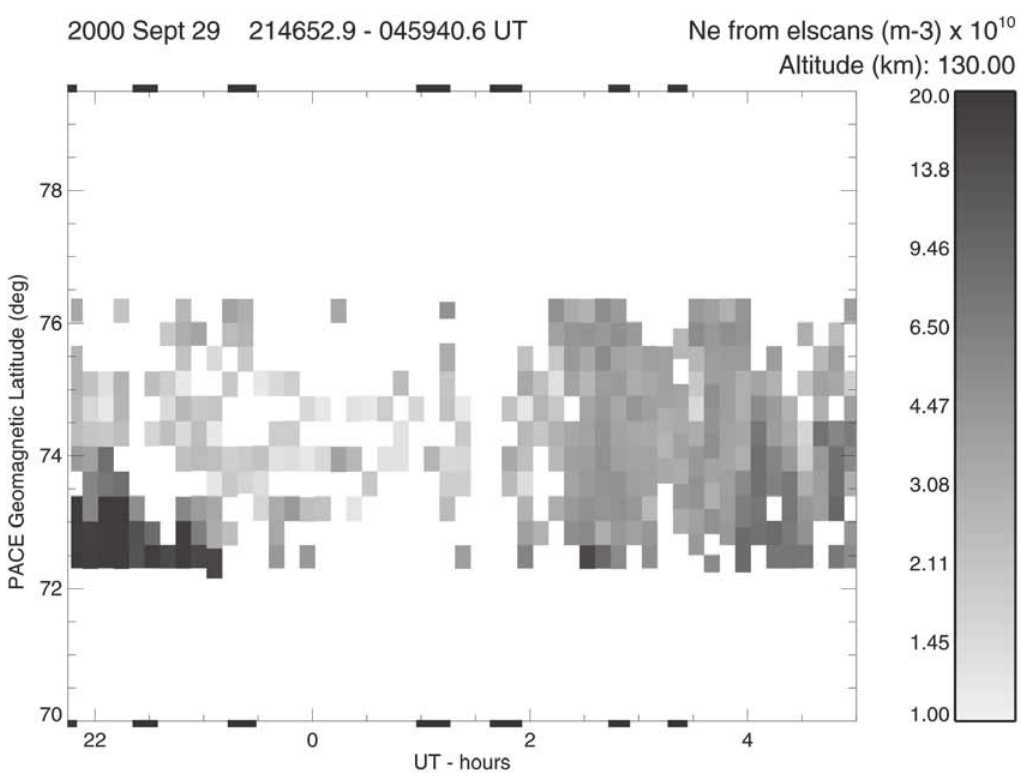
Fig. 6. E region (130 km altitude) plasma density distribution in a format similar to fig.